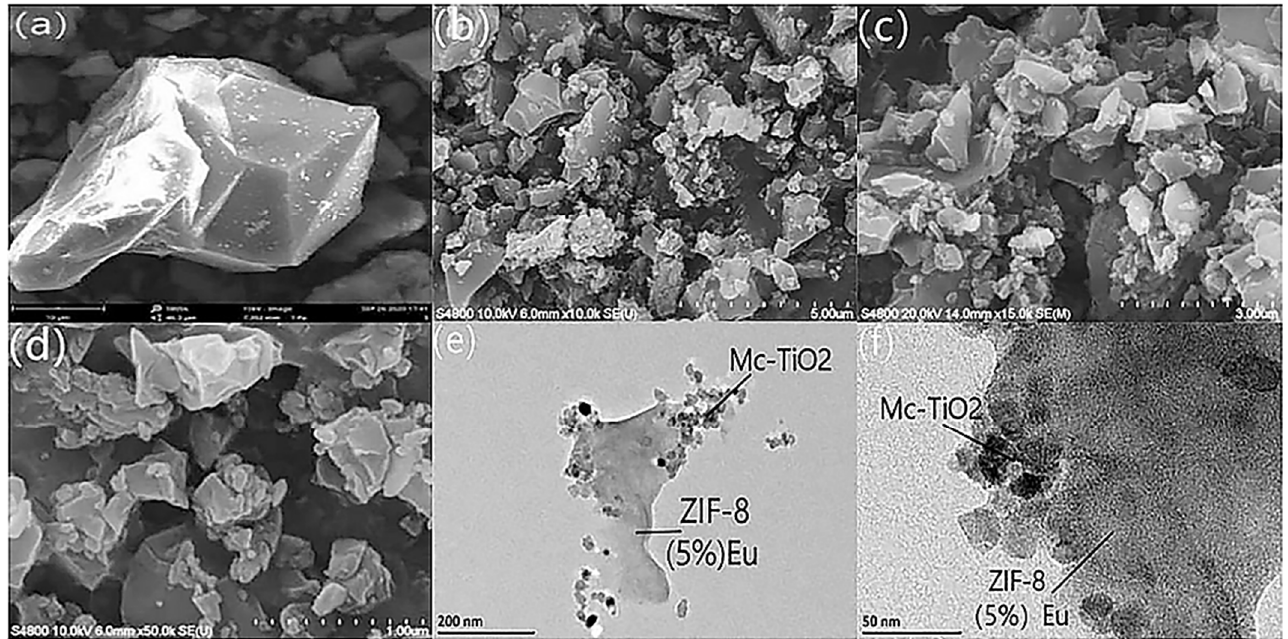
Figure 2. SEM ( a ) of ZIF-8, SEM ( b – d ) and TEM ( e , f ) of ZIF-8 (5%Eu)@Mc-TiO 2